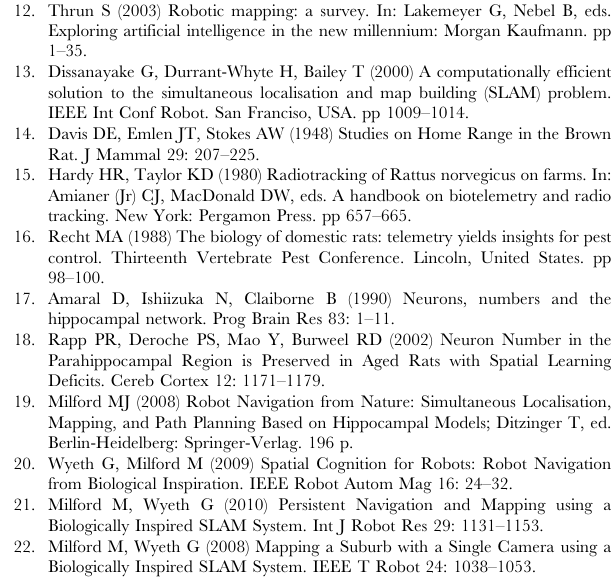
ensemble cell firing (see Figure 10). After initial placement at corner C (bottom right) facing corner D (bottom left), the robot estimates. These location estimates are updated as the robot moves towards corner D. After turning corner D and seeing a second black cue, the cell firing supporting the correct location